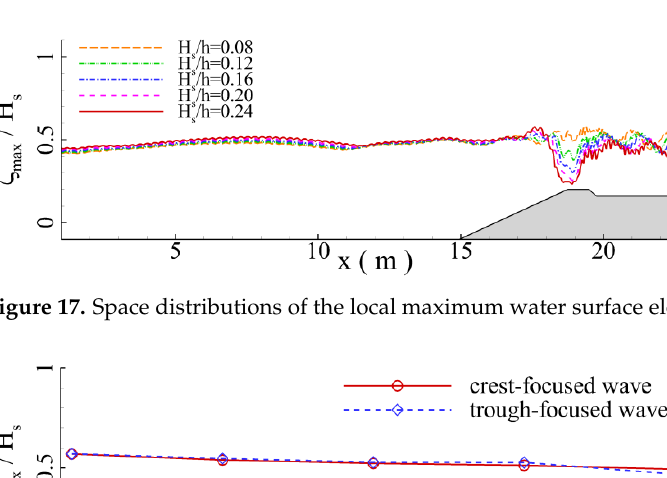
Figure 16. Spatial – temporal evolutions of the water elevation along the simulation zone; ( a ) H s / h = 0.08; ( b ) H s / h = 0.12; ( c ) H s / h = 0.16; ( d ) H s / h = 0.22; ( e ) H s / h = 0.24.